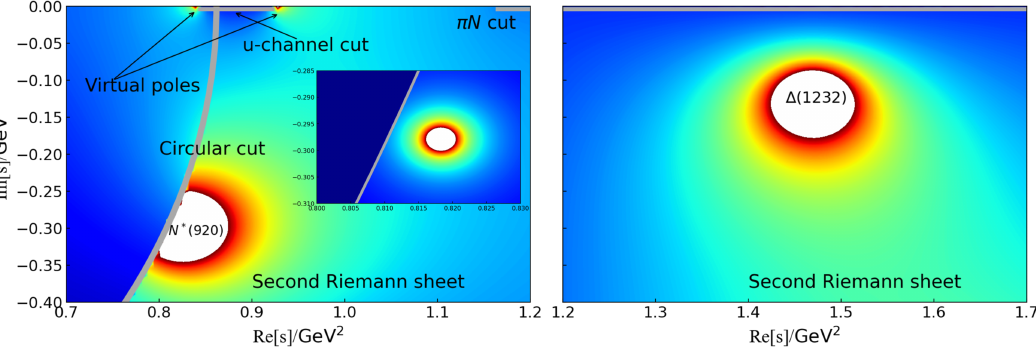
Figure 4 . Left: | S 1 / 2 II | on the s plane, where N ∗ (920) pole is clearly visible; right: | S 3 / 2 II 0+ including ∆(1232)